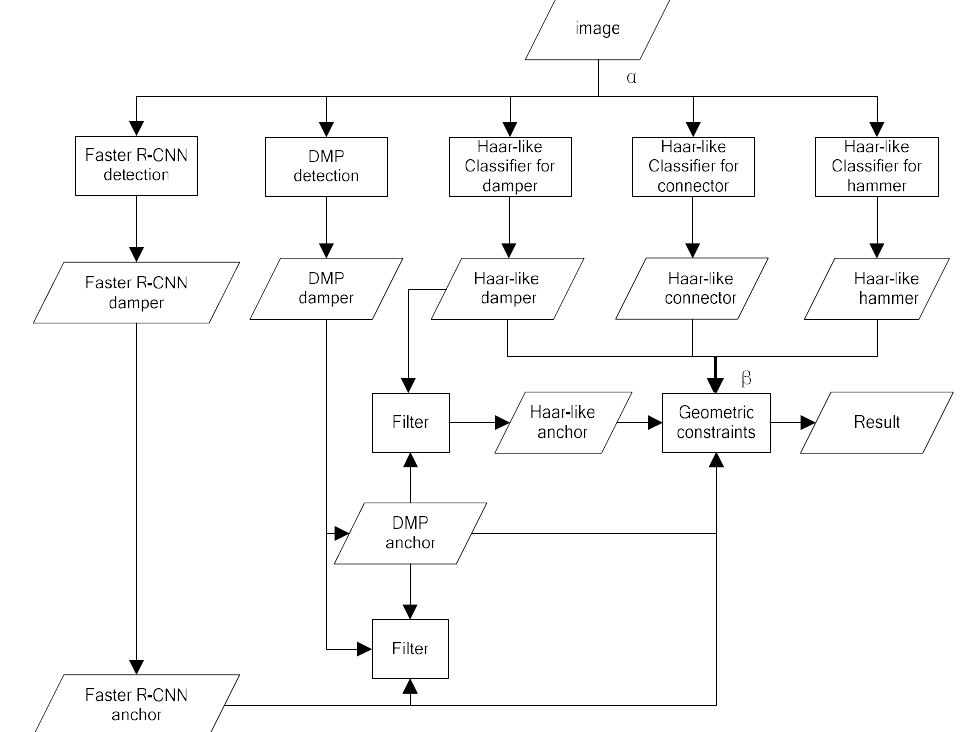
Figure 3. Classifier combination flow chart.